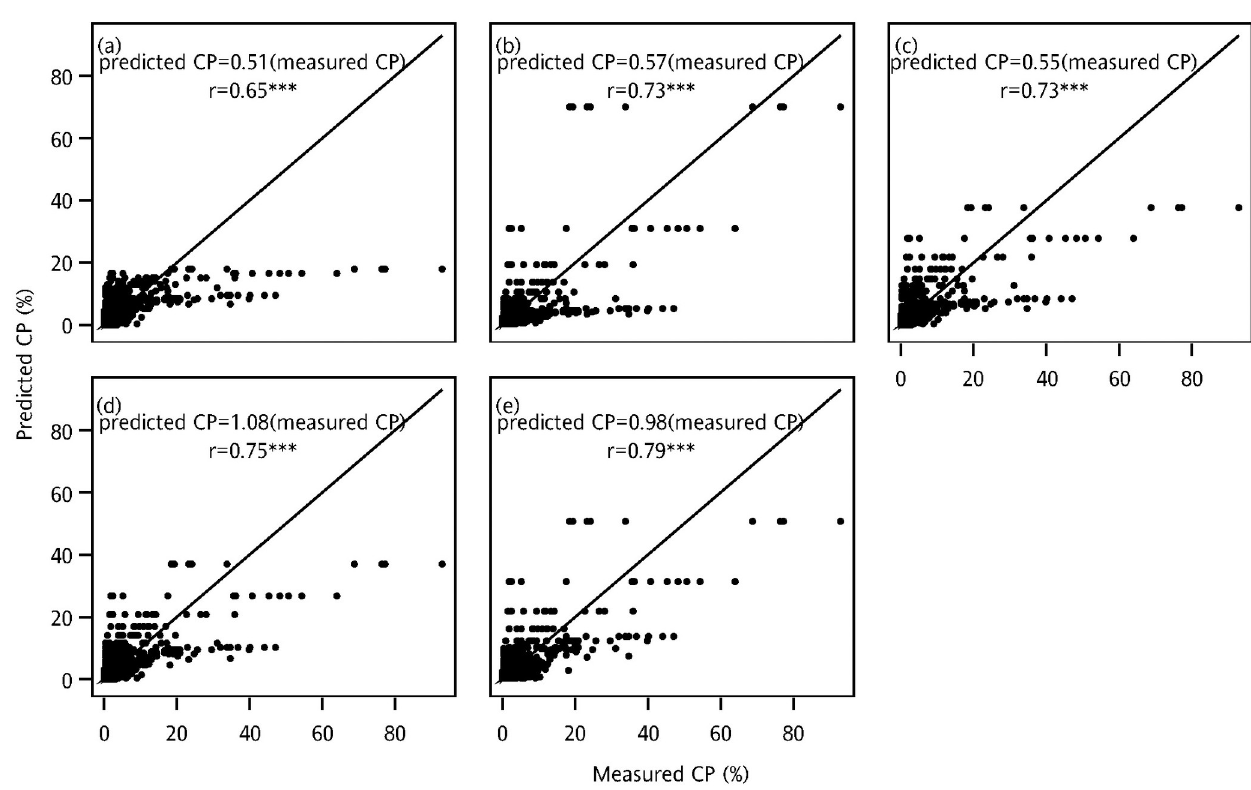
Fig 5. Scatter plots of measured and predicted CP values in the validation set. Models (a) CP 1 , (b) CP 2 , (c) CP 3 , (d) CP 4 , and (e) CP 5 ( ��� : p < .0001).